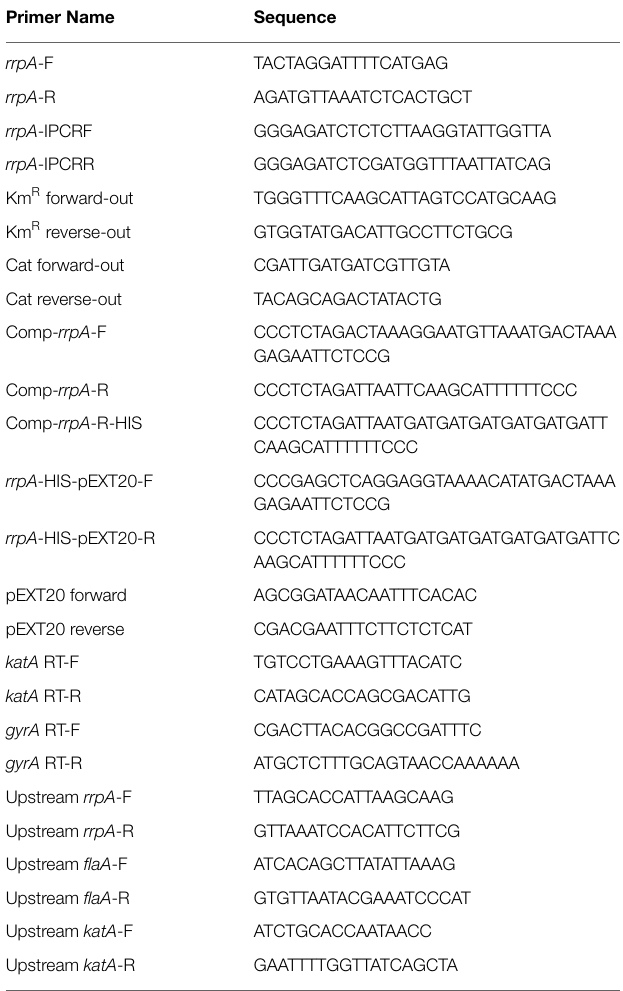
TABLE 2 | Oligonucleotide primers used in this